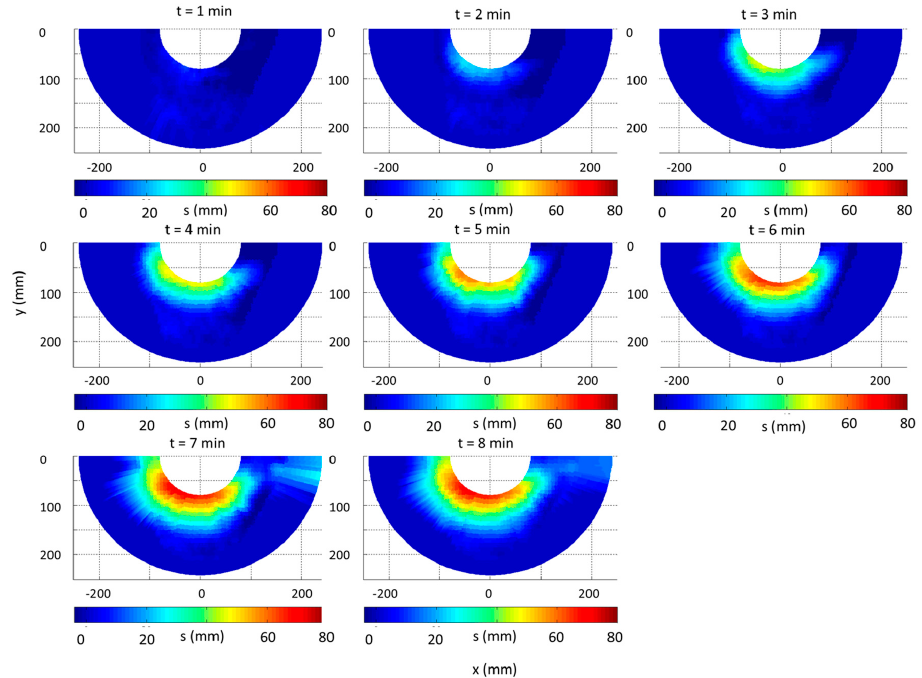
Figure 2. Scour depth (s) contour maps during the first 8 min of the experiments. Flow direction is from left to right. t: time.